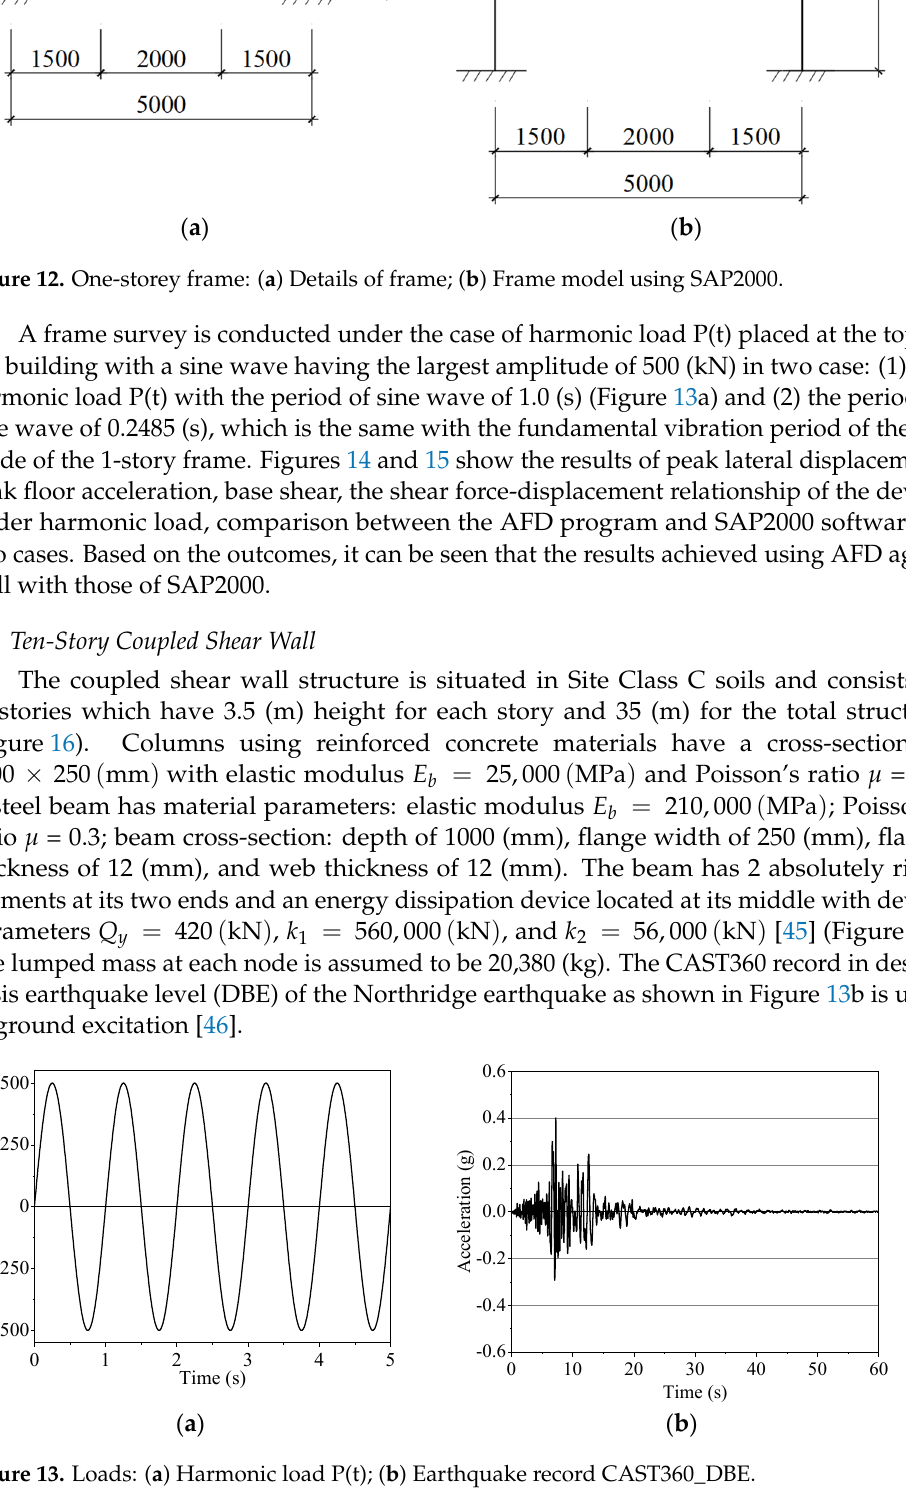
Figure 13. Loads: ( a ) Harmonic load P(t); ( b ) Earthquake record CAST360_DBE.